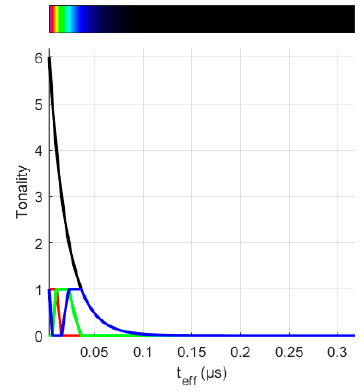
Figure 4. Colour and range selection of the effective time for representing the PRPD- t eff patterns.